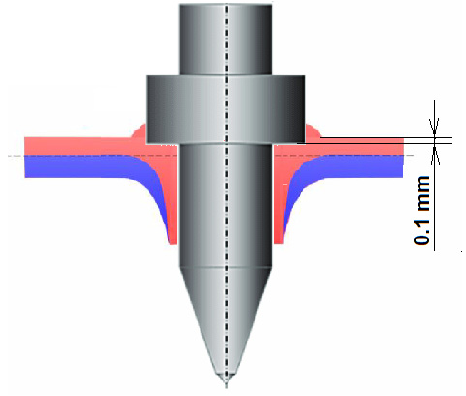
Figure 1. Tool in the lowest reversal position.